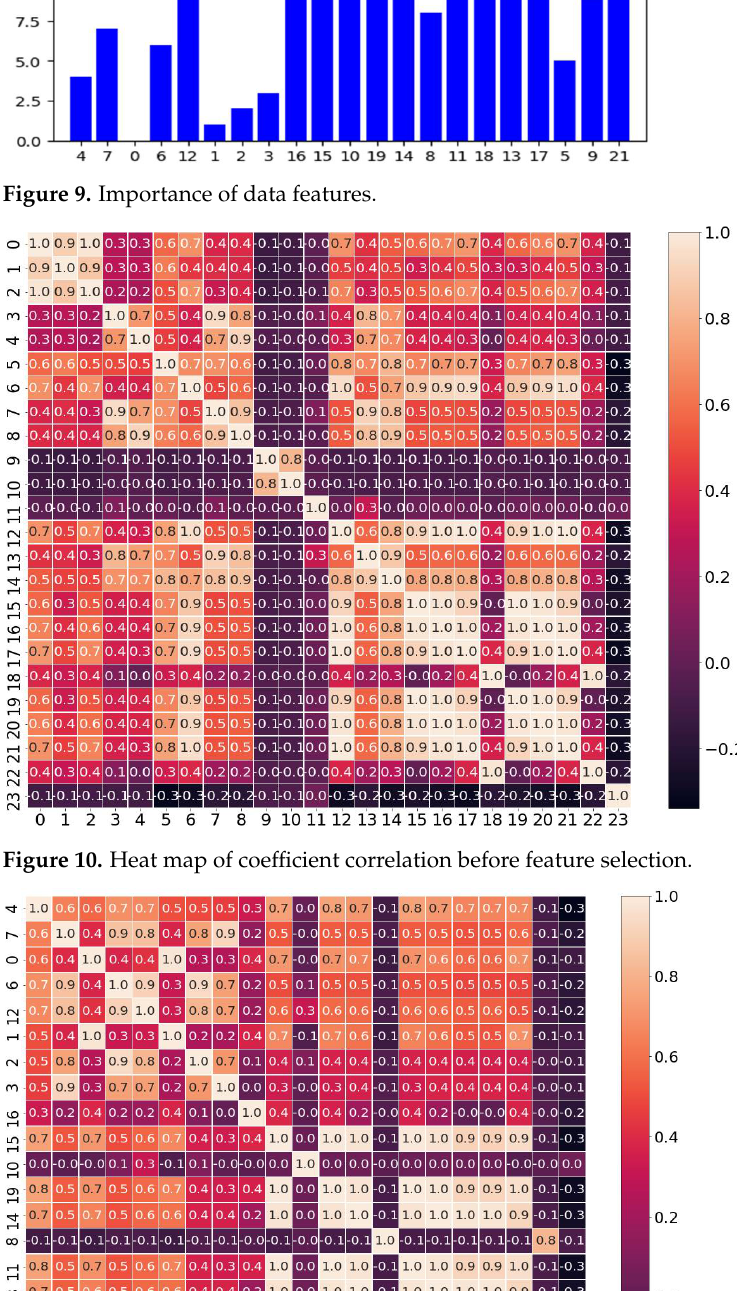
Figure 11. Coefficient correlation heat map after feature selection.